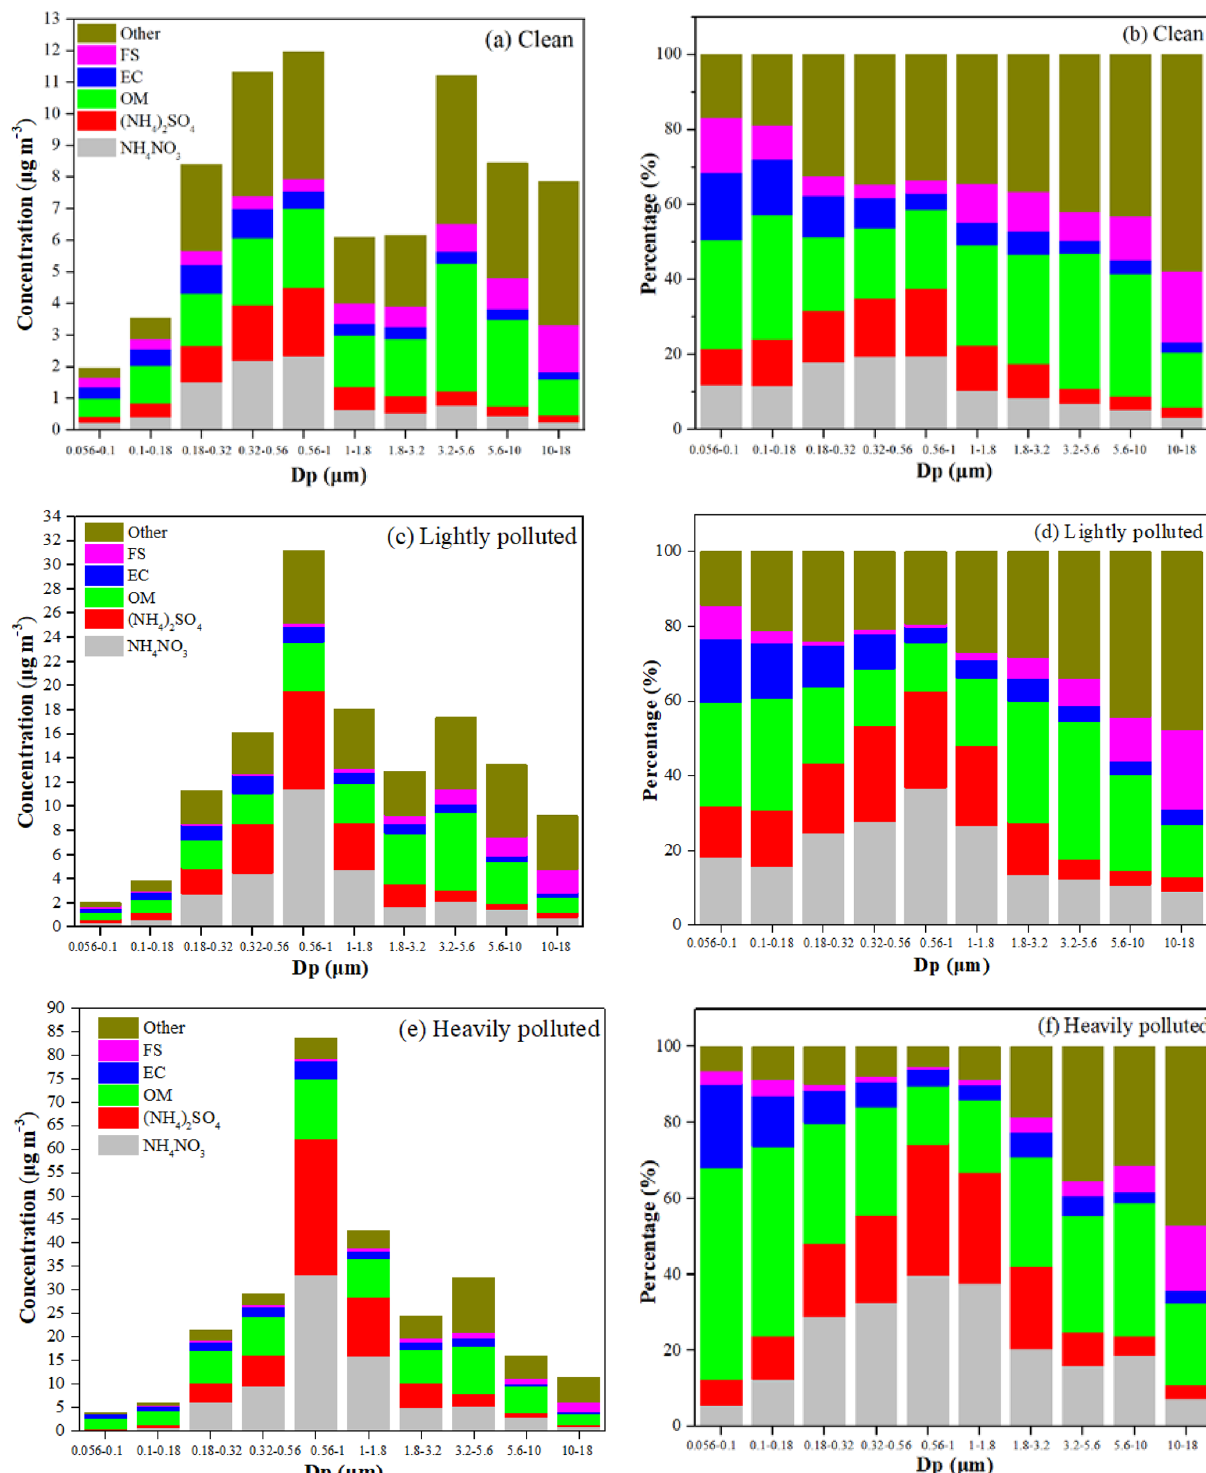
Figure 1. The mass concentrations and fractions of the main chemical components of particles with different sizes in Nanjing on clean, lightly polluted and heavily polluted days during the sampling period. Dp refers to the particle